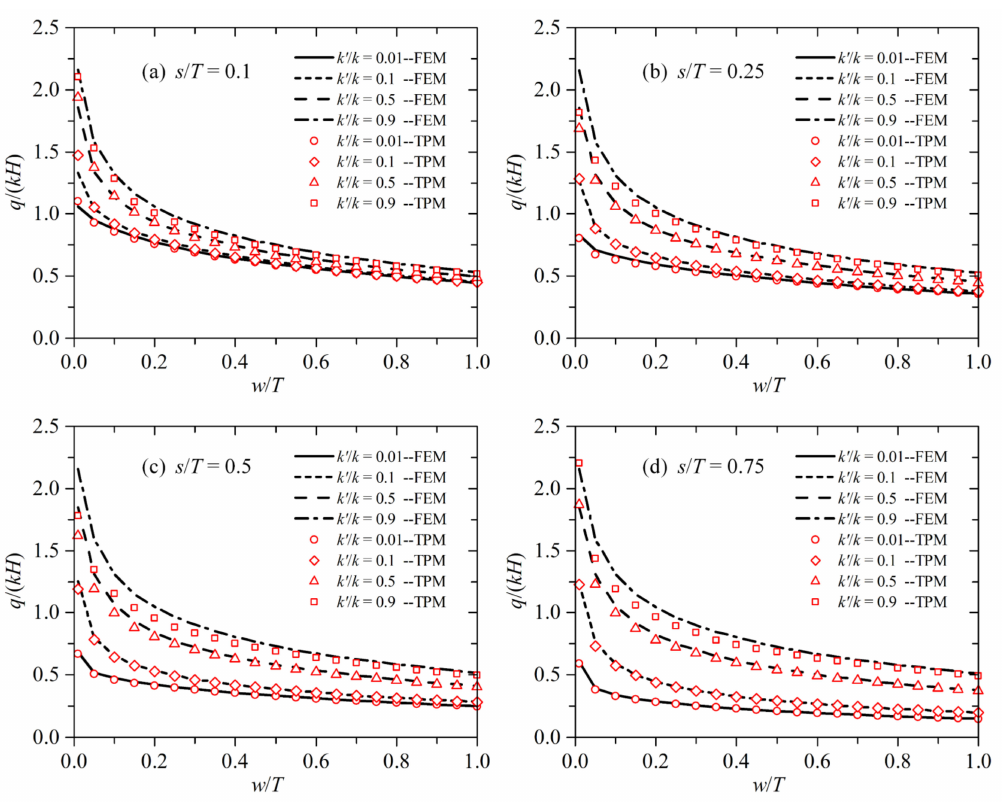
Figure 9. Flow calculation results of representative examples for ( a ) s / T = 0.1, ( b ) s / T = 0.25, ( c ) s / T = 0.5, and ( d ) s / T = 0.75.